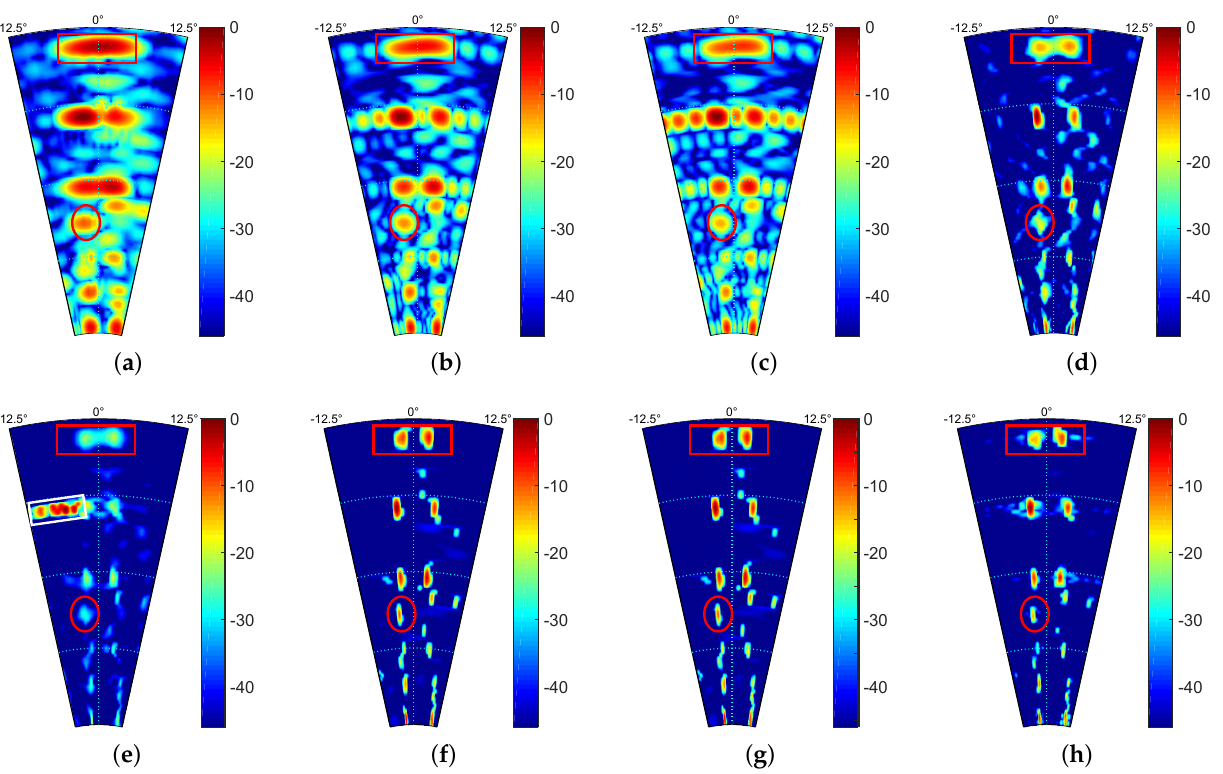
Figure 7. Processed results of Ginkgo Avenue data. ( a ) Real beam echo, ( b ) Result of TREGU, ( c ) Result of TSVD, ( d ) Result of RL, ( e ) Result of IAA, ( f ) Result of SBA, ( g ) Result of FSBA, ( h ) Result of SFSBA.